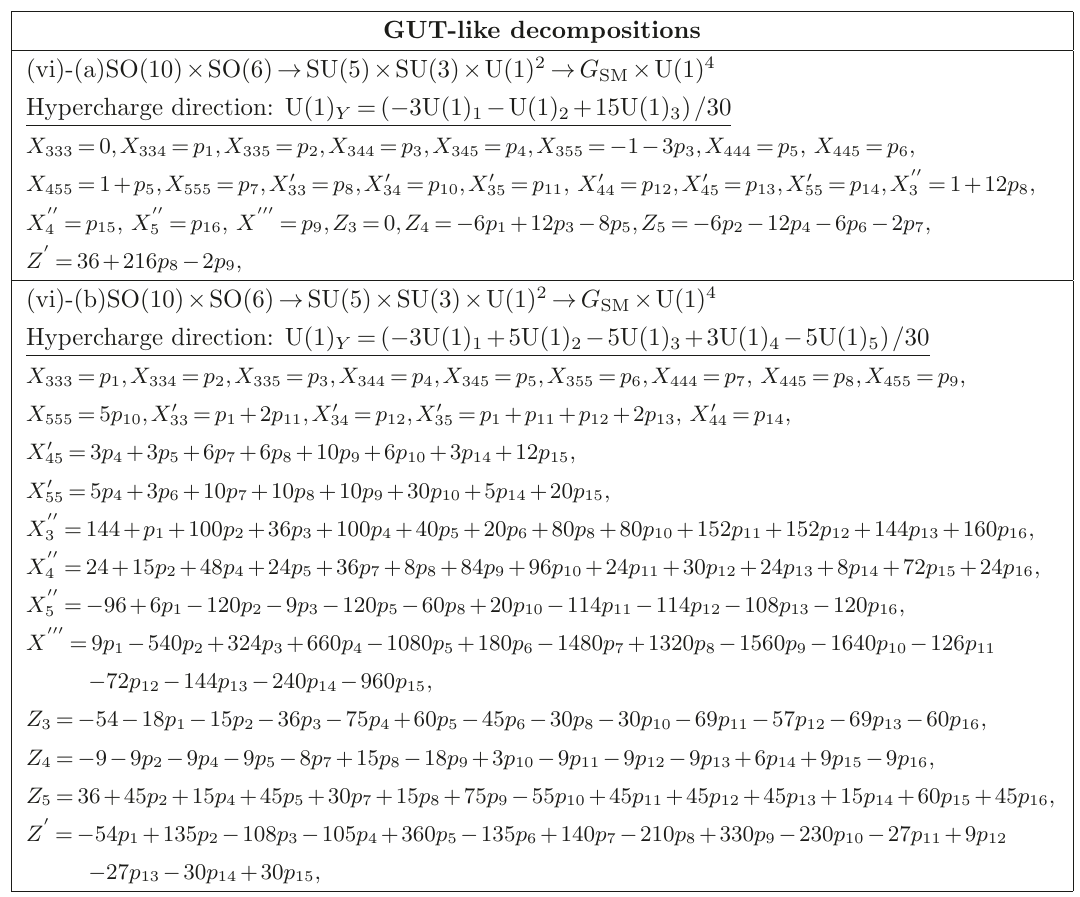
Table 1 : Group decomposition of SO(16) discussed in this paper. In all cases, the hypercharge direction is U(1) Y = 1 Γ denotes the possible order of freely-acting discrete symmetry group of CY threefold, satisfying the phenomenological requirements (2.27) and